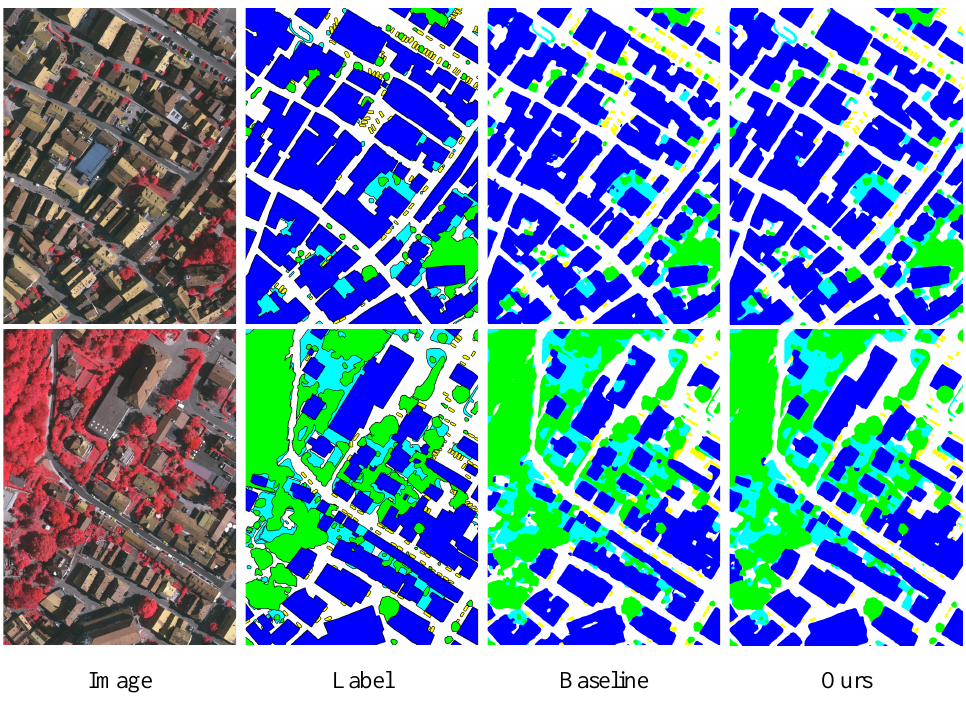
Figure 8. Visualization of the prediction results of the proposed method and the baseline model (FCN) on the original large images of the Vaihingen dataset.